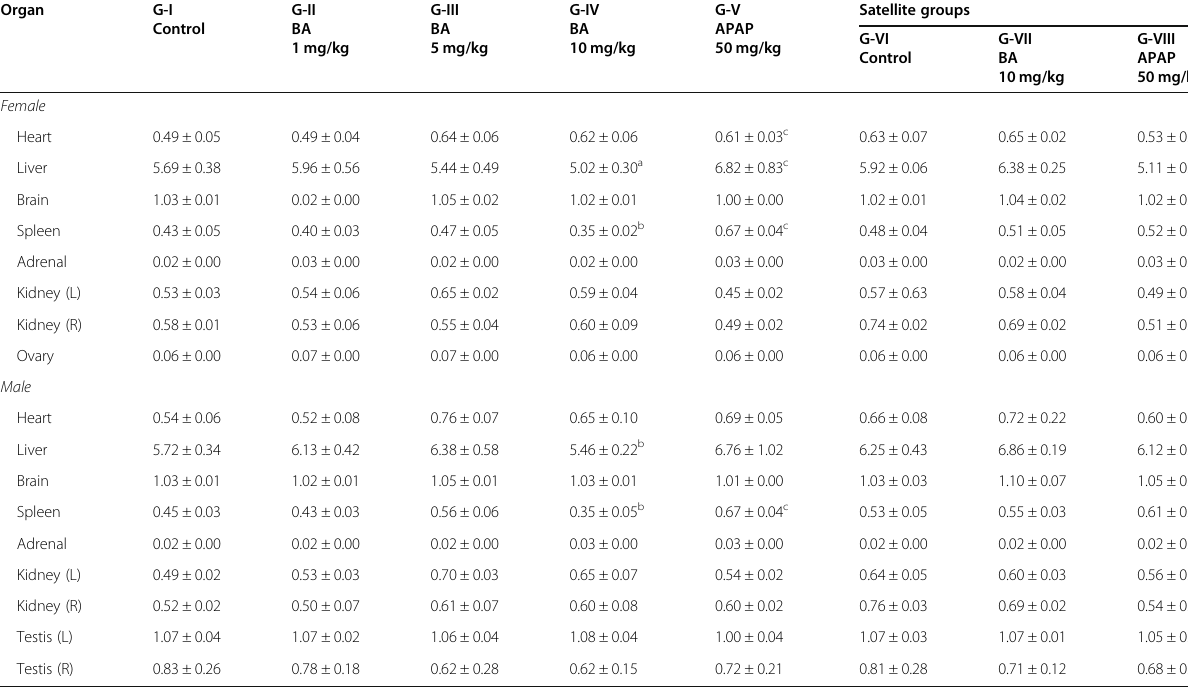
Table 3 Effects of sub-acute oral administration of BA and APAP on ROW of Wistar rats ( n = 5/sex)